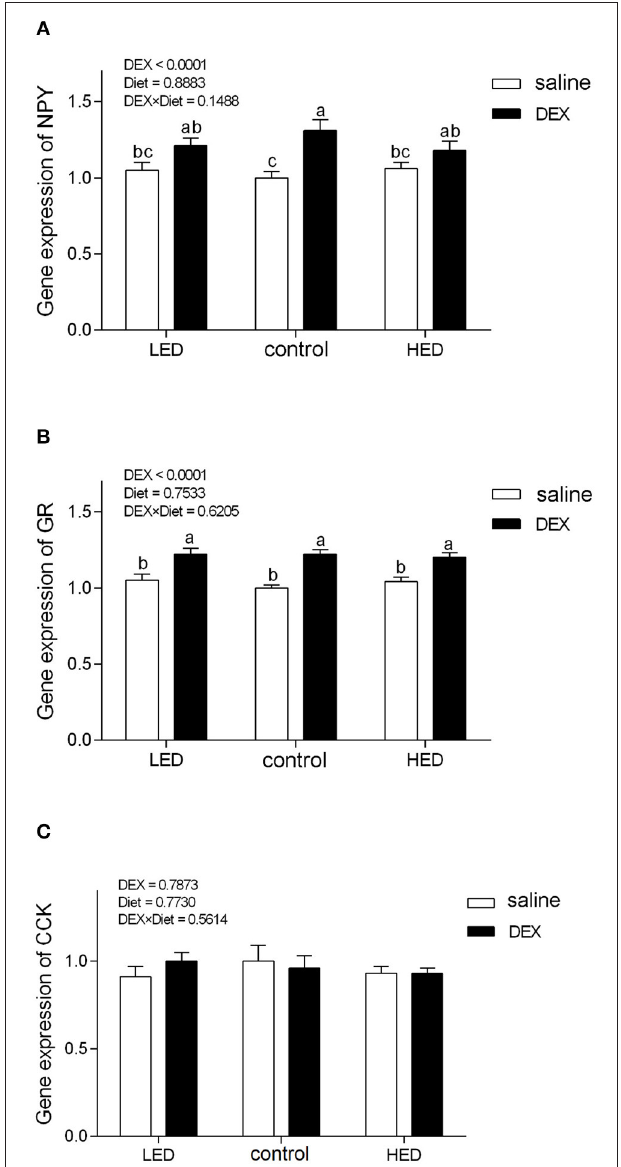
FIGURE 2 | Effects of DEX on the mRNA expression levels of NPY (A) , GR (B) , and CCK (C) in the hypothalamus of 13-day-old broilers fed with different energy level diets. Values were obtained from duplicates of each sample and are presented as mean ± SEM ( N = 8). a,b,c Means sharing no common letters differ significantly ( P < 0.05; ANOVA). LED, low energy diet; control, National Research Council-recommended diet; HED, high energy diet;